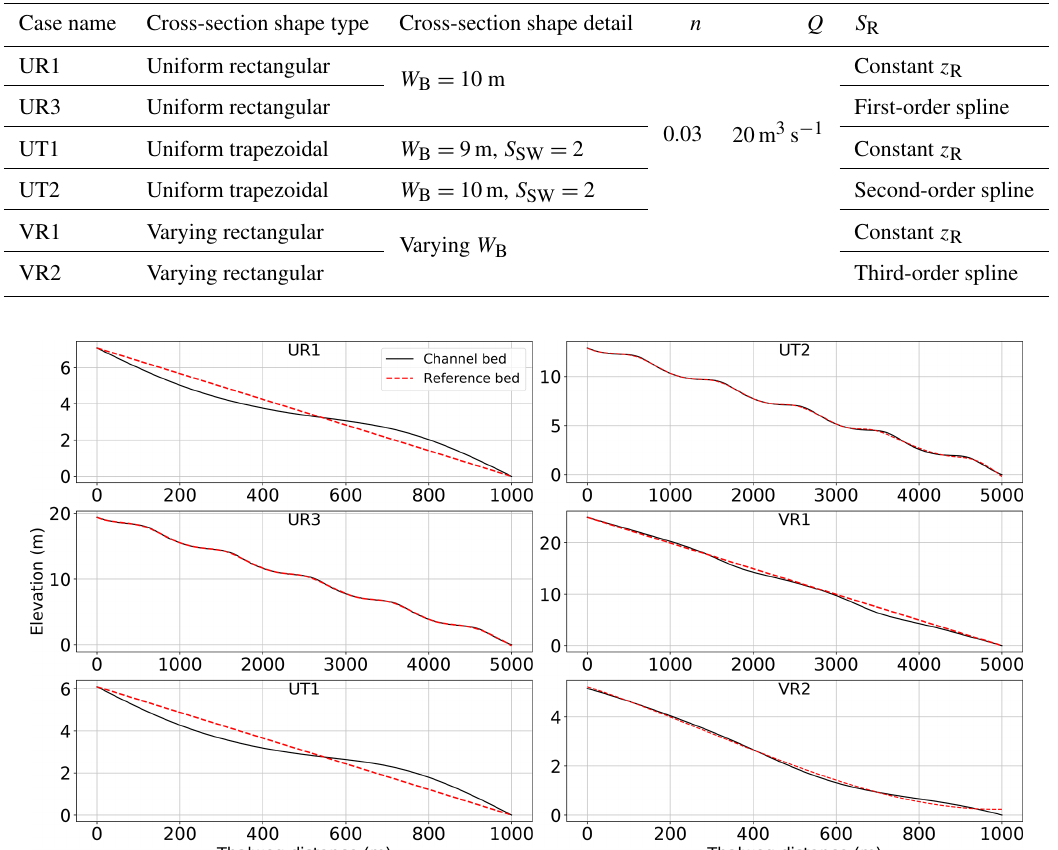
cross sections with spacing ranging from 10.1 to 184.9